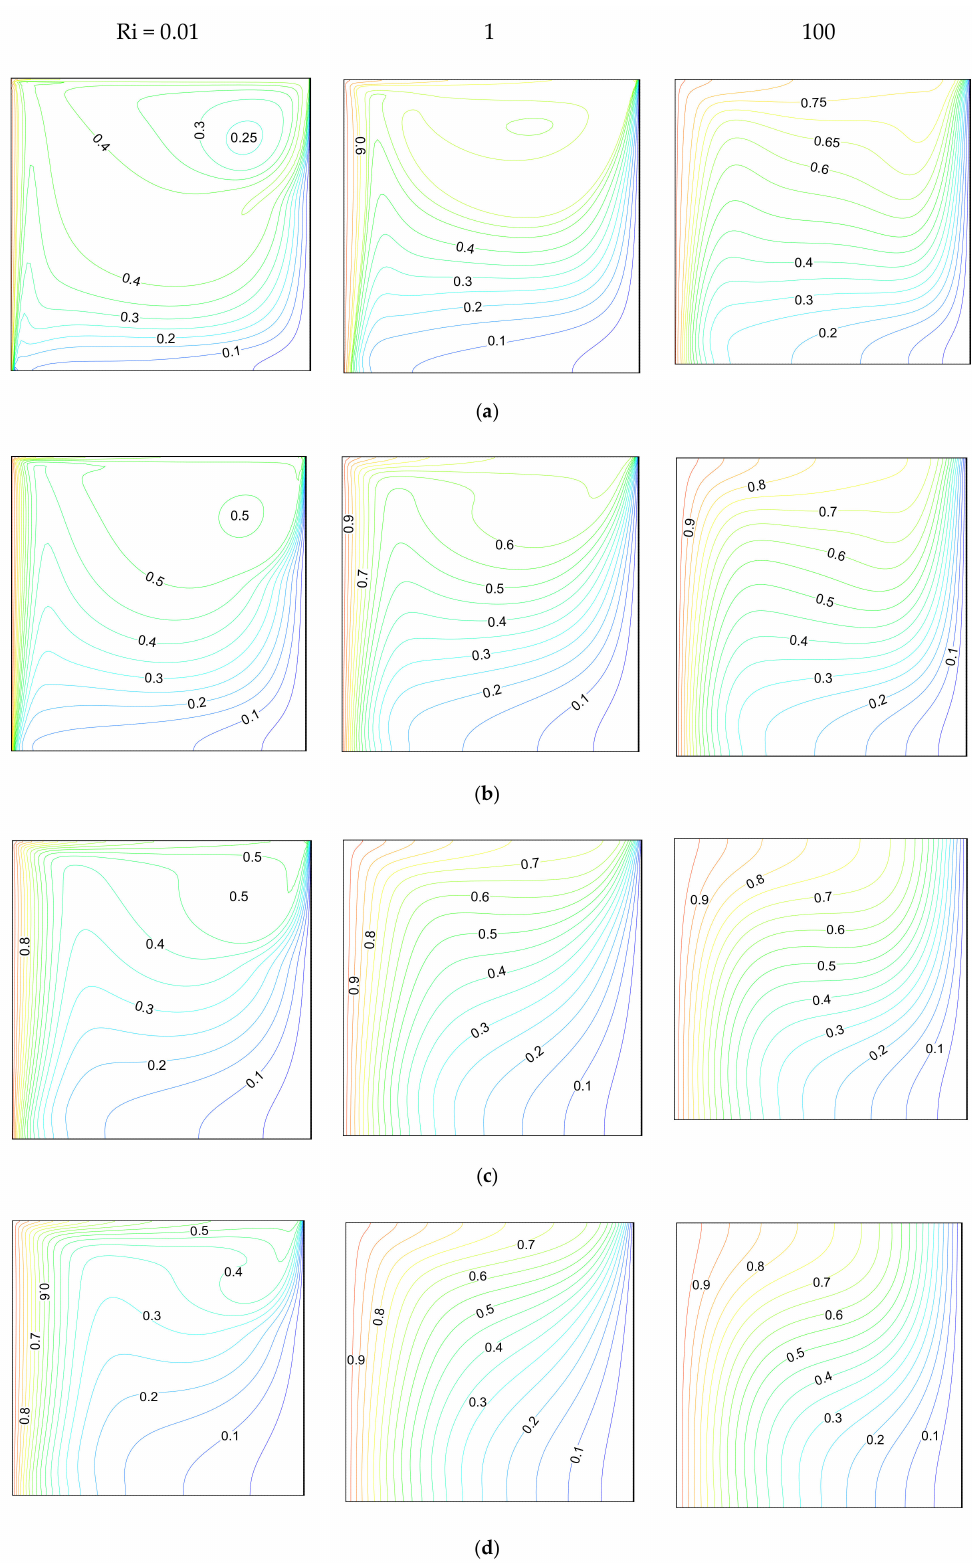
Figure 4. Isotherms for diverse Rd and Ri values with U 0 = + 1 (Case 1) and Φ = 0.02. ( a ) Rd = 0; ( b ) Rd = 1; ( c ) Rd = 5; ( d ) Rd =